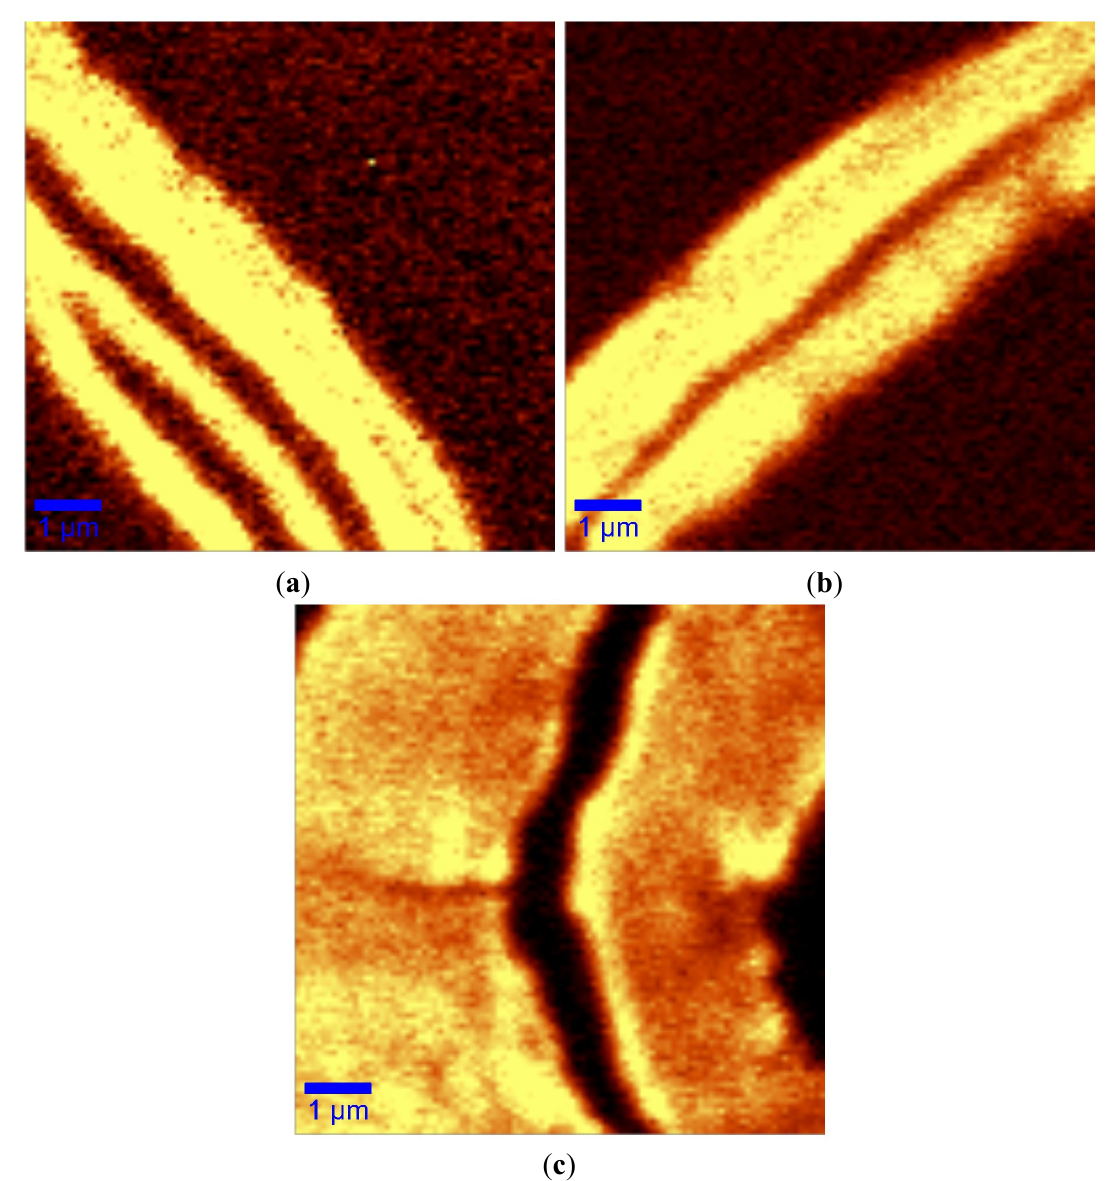
Figure 2. Confocal Raman images of fiber cross-sections at different developmental